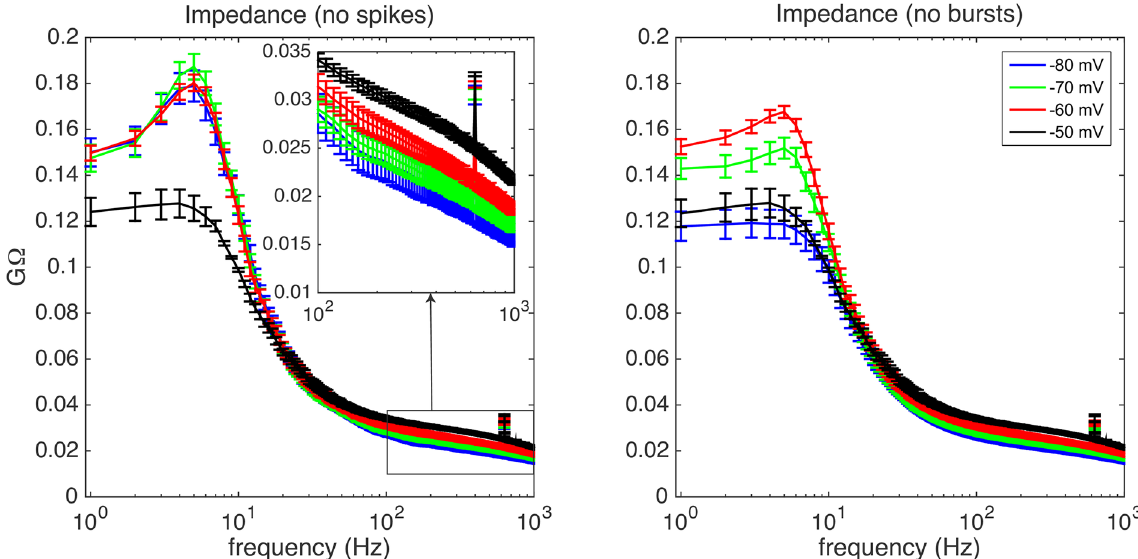
Fig 3. Transfer function of a TCR neuron in vitro . Impedance of the TCR neuron calculated as the amplitude of the transfer function between current input and voltage output for the four defined membrane states (blue: − 80 mV, green: − 70 mV, red: − 60 mV, black: − 50 mV). Left: A small time window was cut out and interpolated around each single spike to avoid contamination of the spectra by the fast spikes. Inset: zoom with one in ten data points on the frequency range between 100 and 1000 Hz. Right: same data, but now with also a larger cut-out window around each burst including the LTS. Note the resonance peak around 5 Hz that is related to bursting: absent in the − 50 mV trace and considerably reduced if we cut away the LTSs in the left panel. Error bars reflect standard error of the mean.